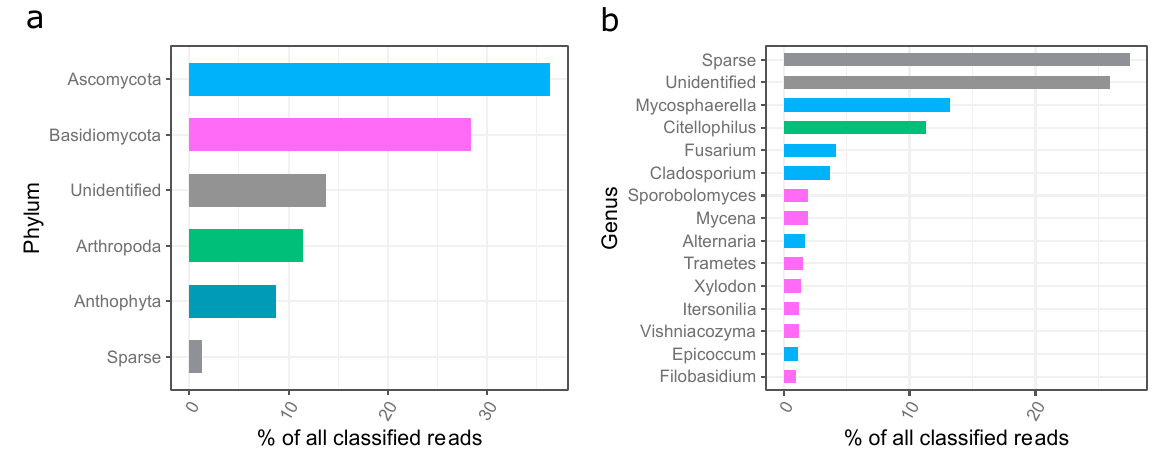
Figure 5. Phylogenetic distribution of fungi sequences in the settled dust sample; ( a ) assigned to the phyla, ( b ) assigned to the genera; unidentified—unidentified sequences; sparse—reads assigned to low abundant phyla (less than 1% of all classi fi ed reads).